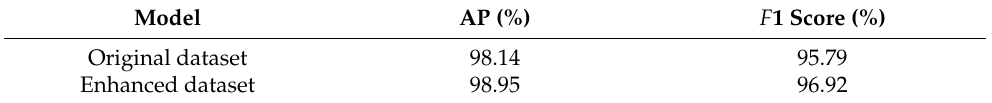
Table 7. Average accuracy (AP) and F 1 scores of the YOLO-SC model corresponding to the two datasets.